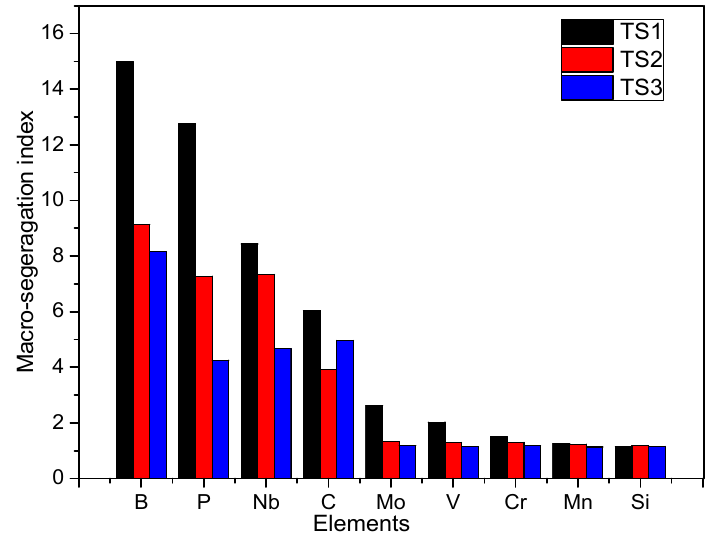
Figure 11. Macro-segregation index ( i macr . ) of the main solutes for three TS samples.